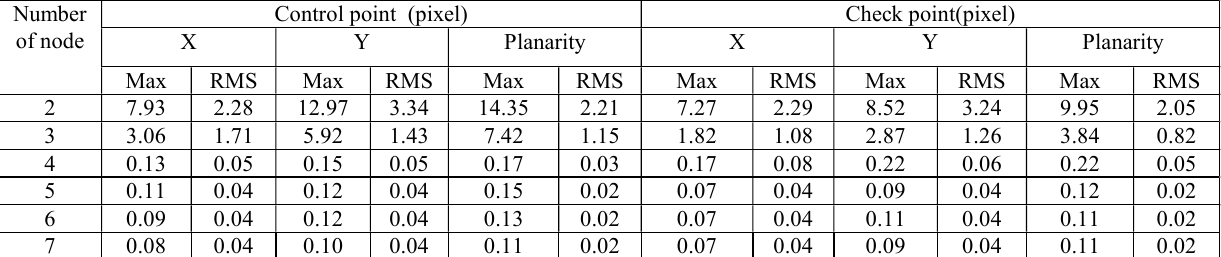
Table 4. BP neural network imagery geometrical model accuracy of dataset 3